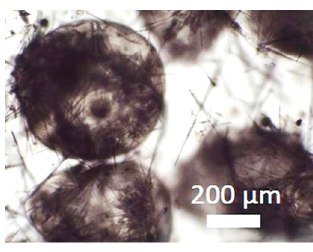
Figure 3. Collected pectin hydrogel particles from the diffusion method with solid needles.